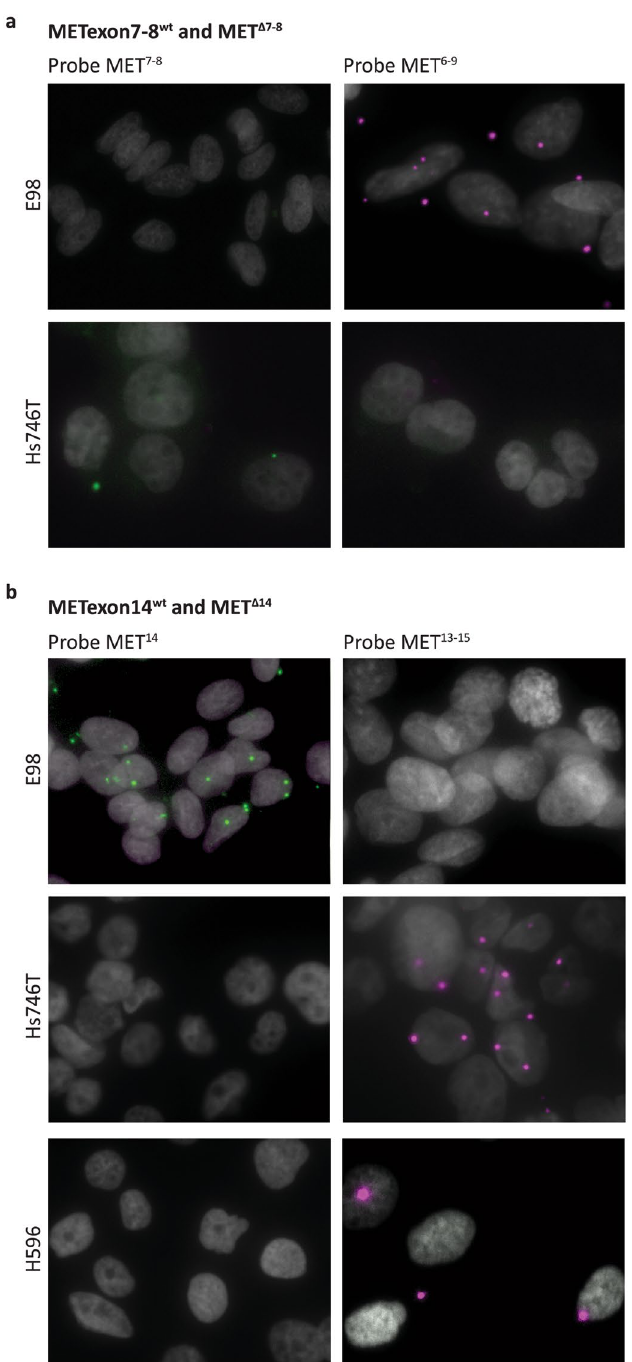
Figure 4. Single-probe in situ mutation detection of MET using padlock probe rolling circle amplification on cell lines. ( a ) In situ detection of METexon7–8 wt and MET Δ 7-8 transcripts in E98 and Hs746T cells using padlock probes MET 7,8 and MET 6–9 , respectively. METexon7–8 wt transcripts are displayed as green RCPs, MET Δ 7-8 transcripts are displayed as magenta RCPs. Cell nuclei are shown in grey. Original magnification 40x. ( b ) In situ detection of METexon14 wt and MET Δ 14 transcripts in E98, Hs746T and H596 cell lines using padlock probes MET 14 and MET 13–15 , respectively. METexon14 wt transcripts are displayed as green RCPs, MET Δ 14 transcripts are displayed as magenta RCPs. Cell nuclei are shown in grey. Original magnification